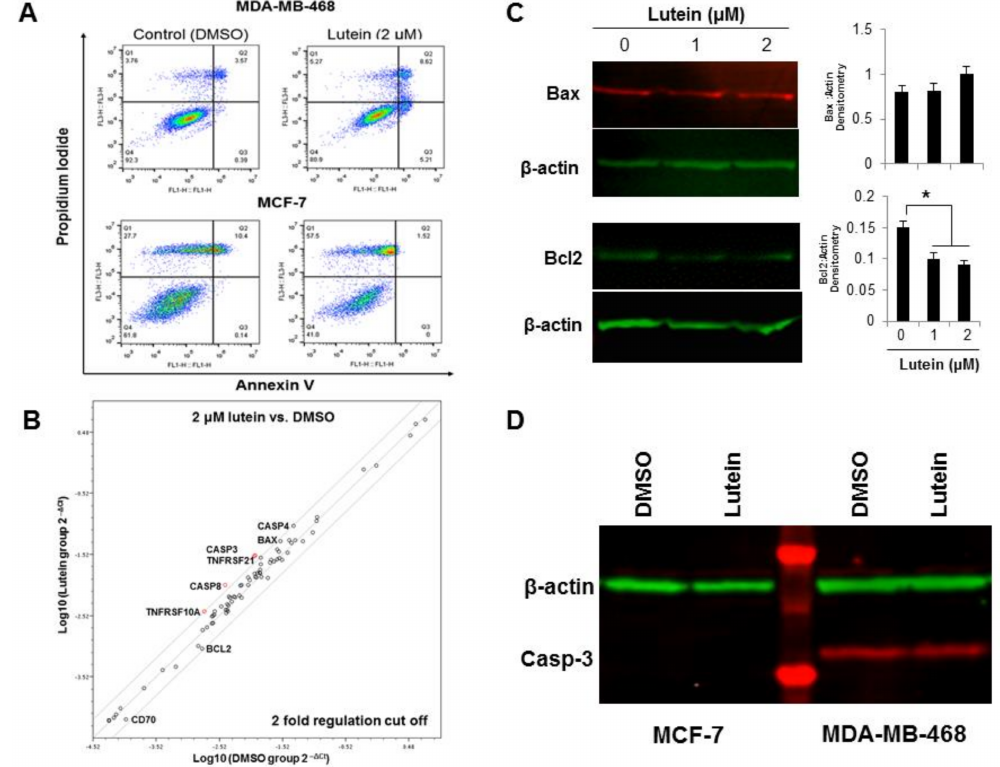
Figure 3. Pro-apoptotic effects of lutein on breast cancer cells. ( A ) MDA-MB-468 and MCF-7 cells were exposed to 2.0 µ M lutein for 24 h. DMSO was used as vehicle control. Cells were processed by flow cytometry using Annexin V/PI staining. The percentage of Annexin V-positive cells indicates the fraction of cells undergoing apoptosis induction. ( B ) Relative expression of 84 apoptosis-related genes comparing lutein-treated MDA-MB-468 cells and DMSO vehicle control. The figure depicts a log transformation plot of the relative expression level of each gene (2 − ∆ Ct ) between untreated control (x-axis) and lutein treatment (y-axis). The gray lines indicate a 2-fold change in gene expression. ( C ) Changes in levels of apoptosis-related proteins by lutein in MDA-MB-468 cells. Cells were treated with 1.0 and 2.0 µ M lutein for 24 h and cell lysates were prepared and subjected to Western blotting for Bax and Bcl-2. The histogram in Figure 3C indicates the average of adjusted Bax and Bcl2 levels (mean ± SD, n = 3). * p < 0.05. ( D ) Western blot analysis of caspase-3 cleavage in MDA-MB-468 and MCF-7 cells. Cells were treated with 2.0 µ M lutein for 24 h and cell lysates were prepared and subjected to Western blot for